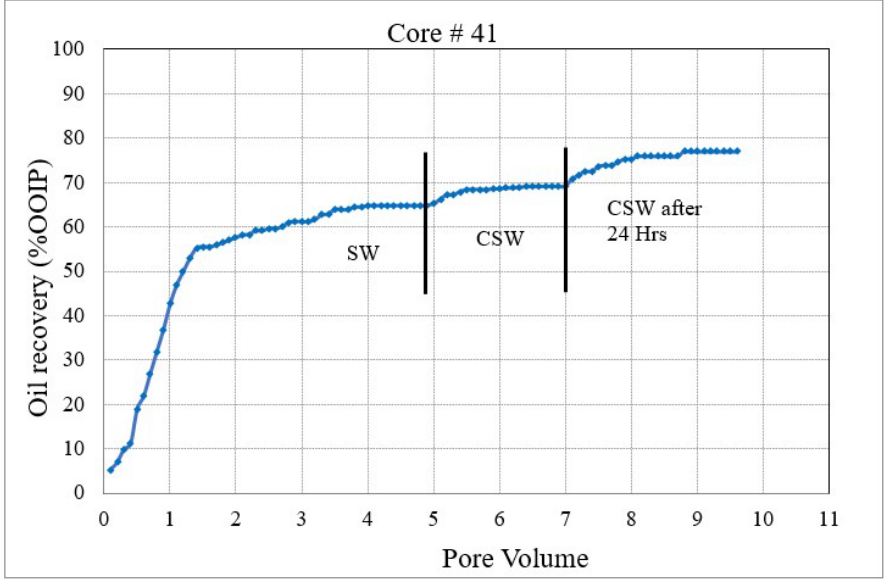
Figure 4. Coreflood with carbonated seawater (CSW). (CF-3 conducted on core plug #41).